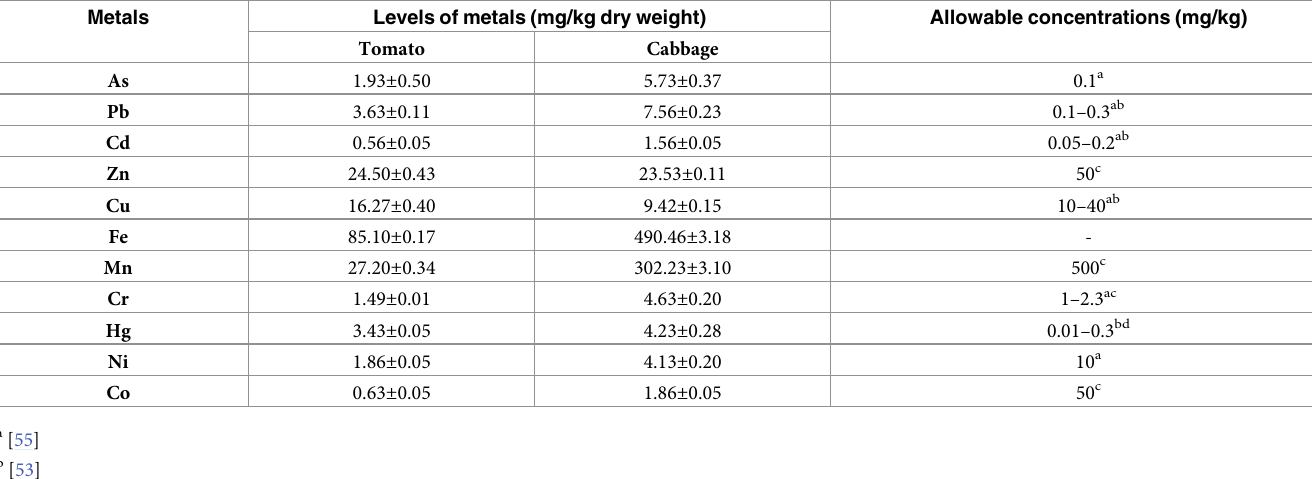
Table 4. Levels of heavy metals (mg/kg dry weight) in tomato and cabbage samples cultivated around Mojo area farmlands in central